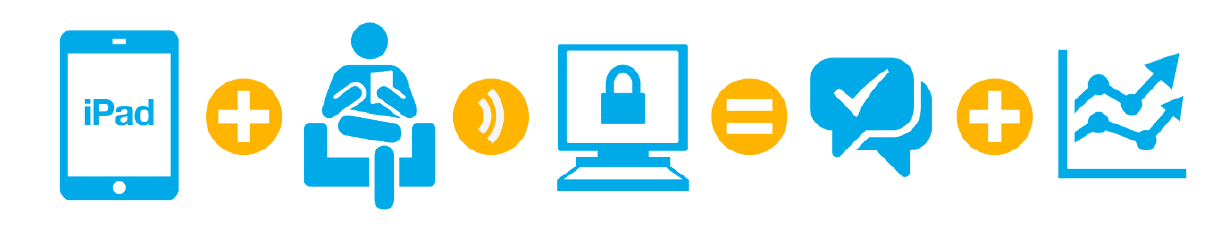
Figure 1. TickiT process